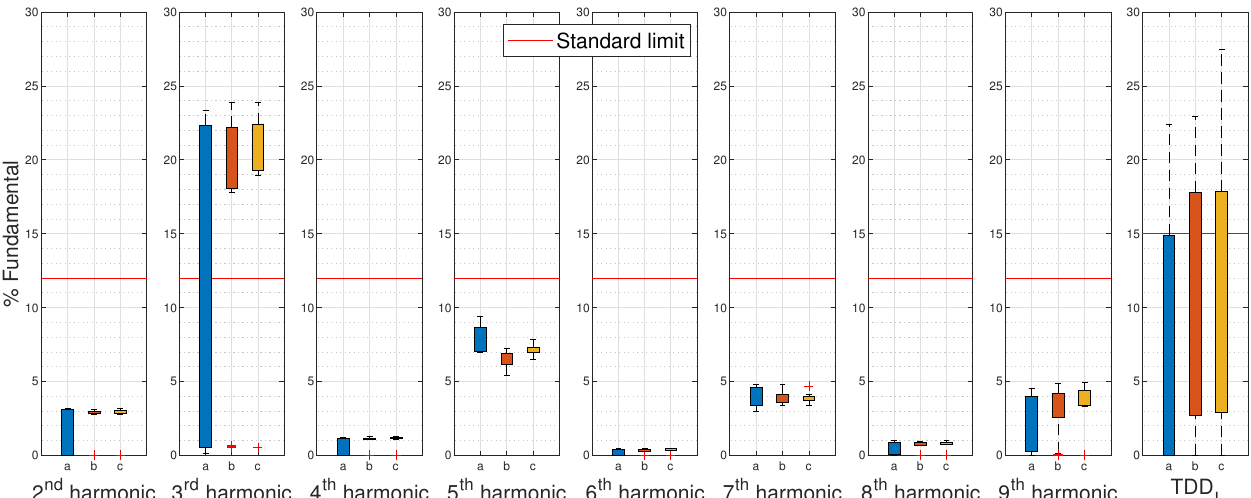
Figure 12. Current harmonics per phase injected by the charging